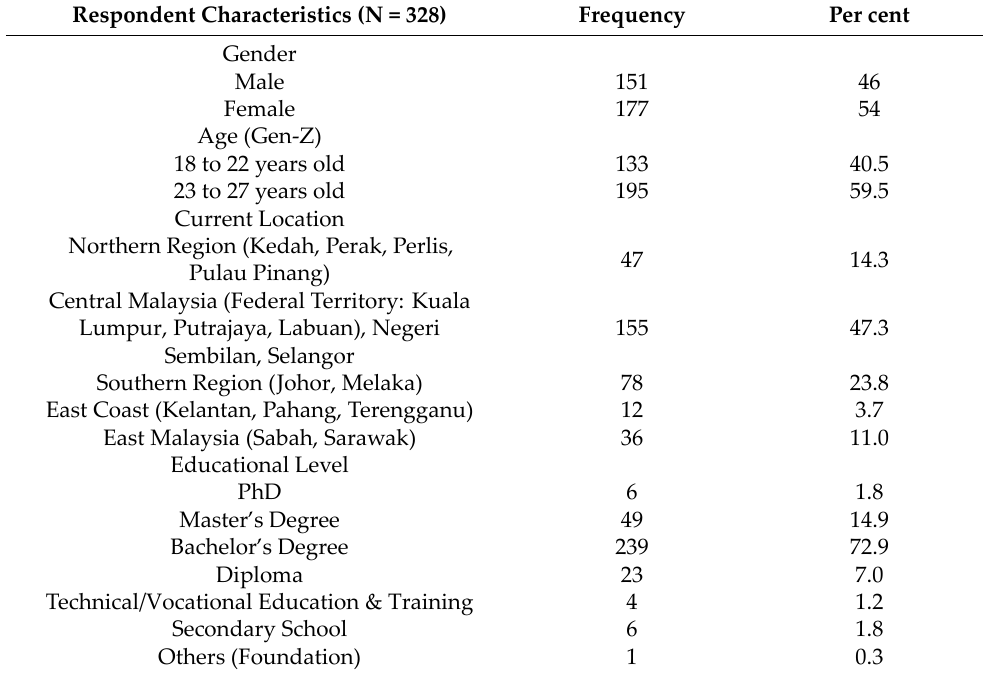
Table 1. Demographic